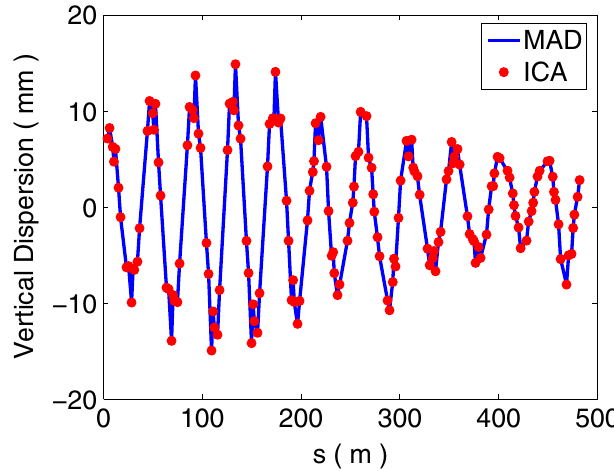
FIG. 3. (Color) The ICA derived dispersion function is com- pared with the MAD modeling based on a QBA low emittance lattice.